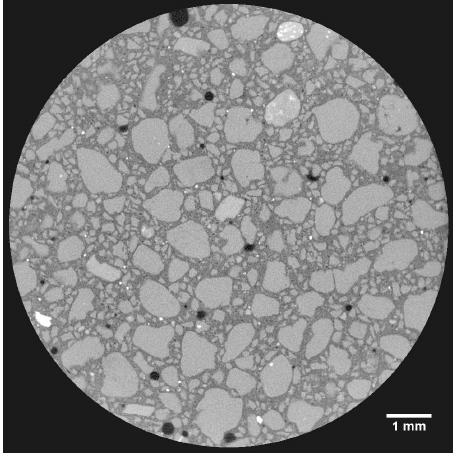
Figure 12. Slice of X-ray tomography for sample NQ.